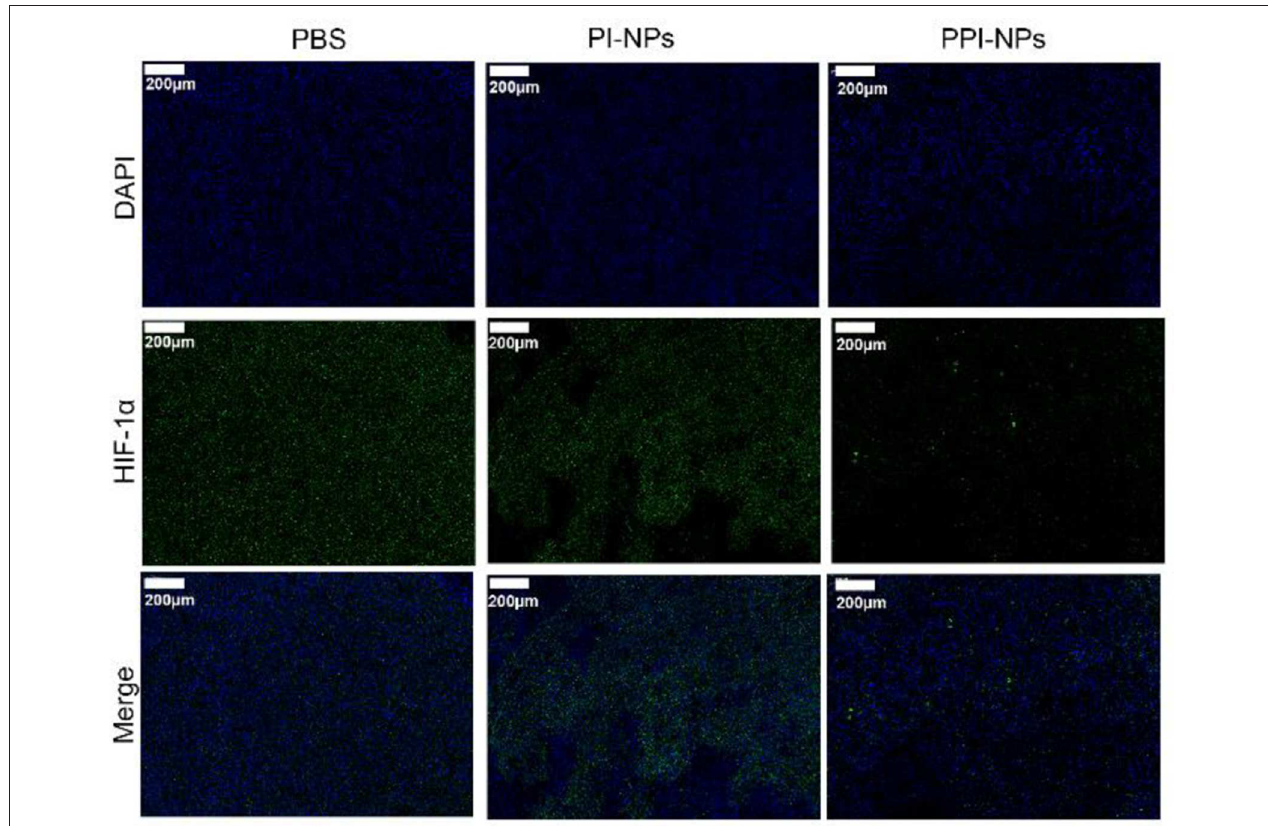
FIGURE 6 | Representative immunofluorescence images of tumor slices stained by the HIF-1 α under different treatments (scale bar, 200 µ m).